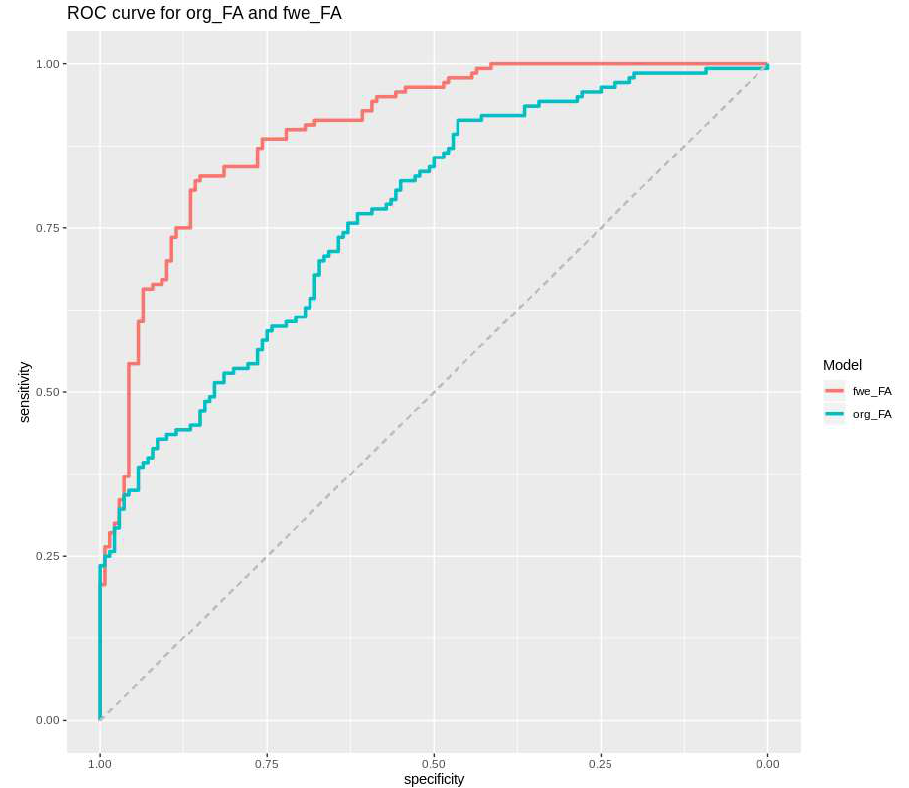
Figure 5. Receiver-operating-characteristic curves for a generalized mixed-effect model to predict later recurrence on the basis of free-water-corrected (FWC) FA values (red curve; AUC = 0.9) or noncorrected FA values (turquoise curve; AUC = 0.77). Both models were threefold cross-validated.